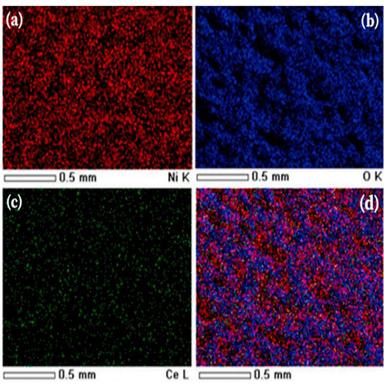
SEM mapping image for Ni (a),O(b), Ce (c) and Ce: NiO 5% doped films(d).